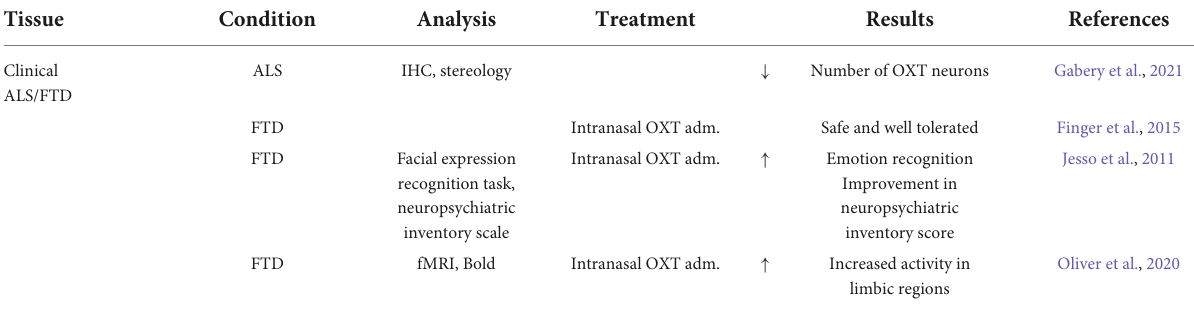
TABLE 2 Summary of oxytocin (OXT) results in amyotrophic lateral sclerosis (ALS) and frontotemporal dementia (FTD). Tissue